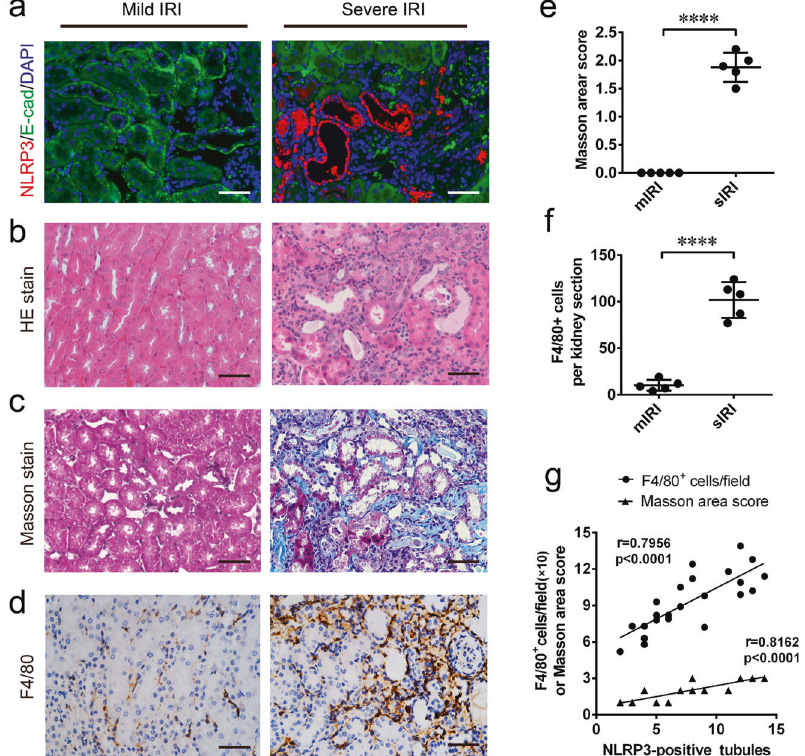
Fig. 3 Tubular NLRP3 upregulation associated with the renal maladaptive repair, and correlated with in fl ammation and fi brosis. a Representative images of co-immuno fl uorescence staining of NLRP3 (red) and E-cadherin (green) in kidney section at chronic phase following AKI. b Representative images of cortex stained with HE. c Representative images of cortex stained with Masson trichrome. d Representative images of immunohistochemistry stain of F4/80 in kidney section. e Analysis and semi-quanti fi cation of Masson trichome evaluated by area scoring. f semi-quanti fi cation of F4/80-positive cells in per kidney section. g Correlation analysis of NLRP3-positive tubules with Masson trichome score ( r = 0.8162) and F4/80-positive cells ( r = 0.7956). 0.5 ≤ |r| < 0.8 de fi ned as Moderately correlated. n = 3 mice for the sham group, n = 5 for mild and severe AKI per time-point group, respectively. Data are mean ± SD. **** P < 0.0001. a – d Bar = 20